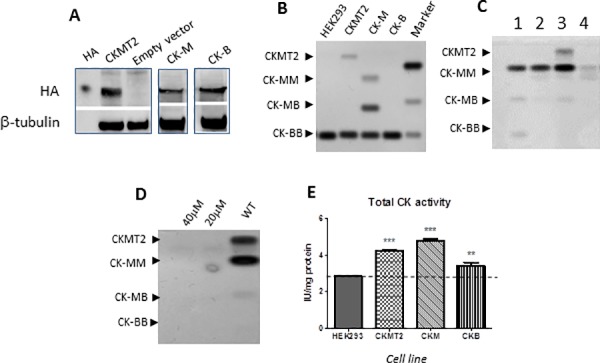
Stable cell line characterization.A. Immunoblotting determined the presence of the HA tag (‘HA’ positive control lane is included). Beta-tubulin was used as a loading control. Black boxes are present where lanes were not run continuously. B. Electrophoresis of CK isoenzymes in all cell lines, namely untransfected HEK293 in addition to CKMT2 (Mitochondrial Creatine Kinase)-, CKM (Muscle Creatine Kinase)- and CKB (Brain Creatine Kinase)-expressing HEK293 cells, followed by a marker lane. Arrows show respective CK isoenzyme bands. CKM migrates slightly faster in HEK293 cells compared to marker. C. Verifying specificity of SAS1 electrophoresis system. Marker (lane 1) in addition to: CKMT2 knockout (KO) heart sample (lane 2), lacking CKMT2 activity; a wild-type (lane 3); a double CKMT2 and CK-M KO (CKd KO), lacking CKMT2 and displaying traces of CK-MM (lane 4). D. DFNB, an inhibitor of CK activity added at 20 and 40 μM. E. Total CK activity in stable CK overexpressing cells was elevated compared to untransfected HEK293. Horizontal axis shows HEK293 untransfected or stable cell type. Data is mean ± SEM. One-way ANOVA and Dunnett’s post-hoc test against HEK293 values. *P<0.05; **P<0.01; ***P<0.001.